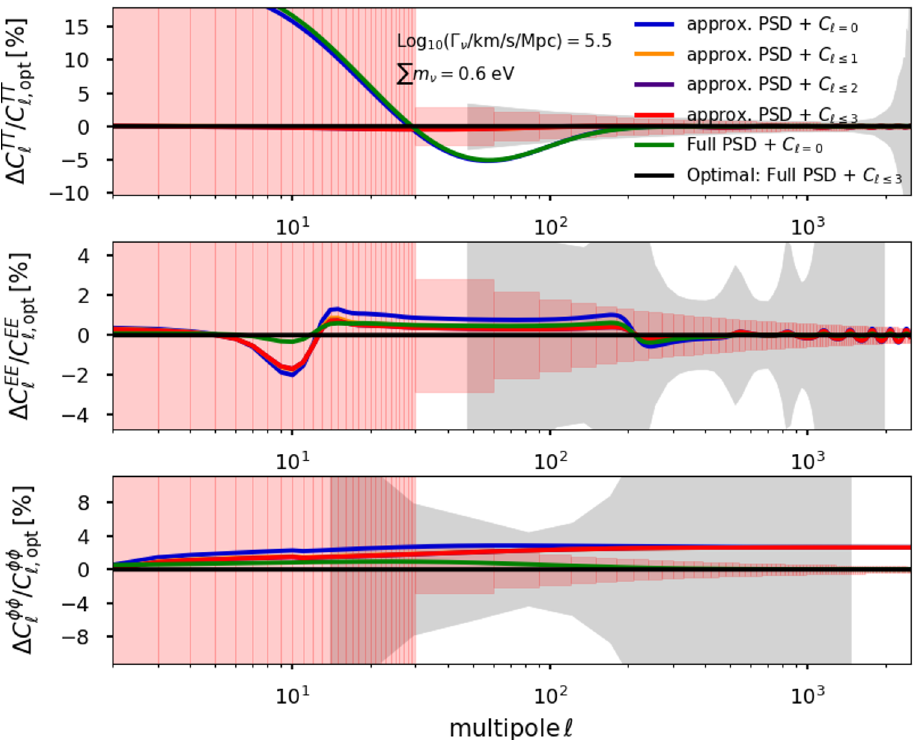
Figure 4 . Fractional change in the CMB TT (upper), EE (middle) and lensing (lower) spectrum, when imposing different prescriptions for the background energy density distribution and Boltzmann hierarchies. “approx. PSD” refers to the approximate phase space distribution in eq. (3.30) while “Full PSD” refers to the exact solution of eq. (3.8). “ C ” in the plot means we only keep those collision ‘ terms in eq. (3.19). The chosen values of the neutrino mass ( P m = 0 . 6 eV ) and decay width ν ( Log (Γ [km / s / Mpc]) = 5 . 5 ) correspond to the case when neutrinos decay close to non-relativistic ν / 10 transition ( T 0 . 3 ). The gray shaded region indicates Planck 2018 1- σ uncertainties, while dec /m ν ’ the pink boxes indicate the (binned) cosmic